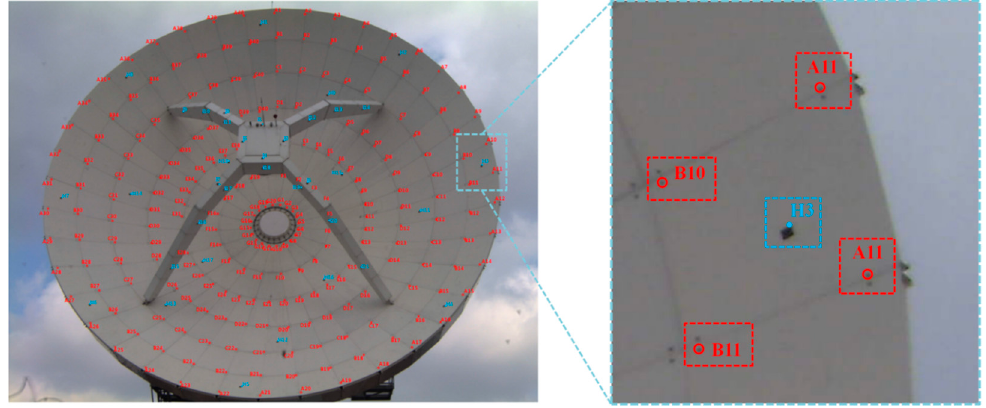
Figure 5. Target labeling for control point surveying and acquisition of image coordinates.